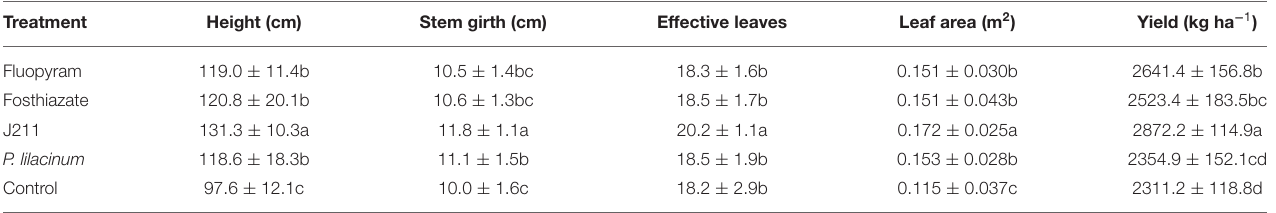
TABLE 3 | Effects of different treatments on agronomic characteristics, yield, and control efficacy of M. incognita in tobacco field assay. Treatment Height (cm) Stem girth (cm) Effective